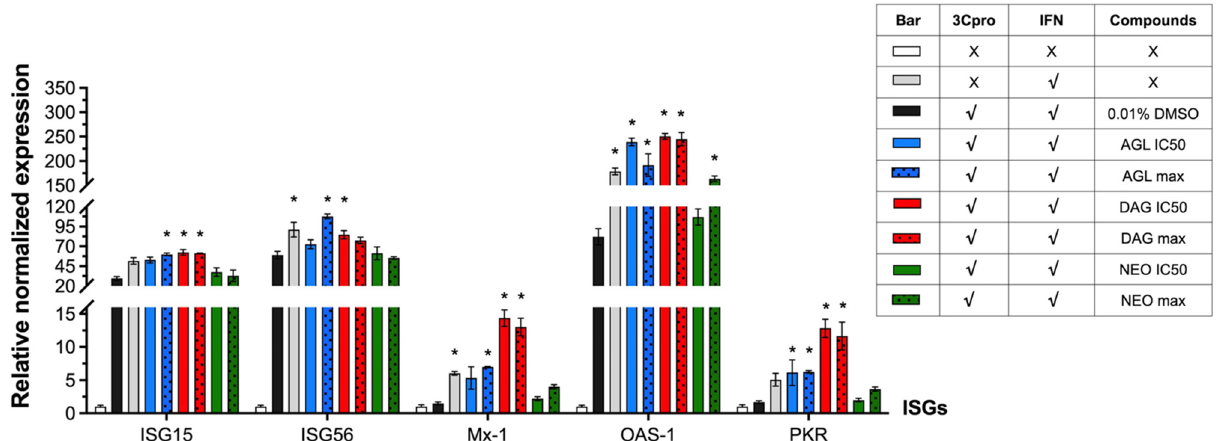
Figure 4. Interference of the andrographolides on inhibition of ISG expression by IFN-antagonist effect of FMDV 3C pro in HEK 293T cells. The cells were transfected with pBV_3ABCD and treated with the compounds at the doses of IC50 and IC90 or CC10. At 24 h after the compound treatments, cells were treated with 1000 IU/mL of IFN β for 8 h. The ISG mRNA levels were analyzed using RT-qPCR. The pBV and pBV_mu3ABCD were included as vector and 3C pro negative controls, respectively (Figure S2). The IFN β -treated, non-transfected cells were used as IFN β control. The data were displayed as the relative ISG mRNA levels of treatments and that of the mock-treated, non-transfected cell control. The experiments were performed in triplicates, and the relative data were presented by means and SD. The asterisks indicate p -value < 0.01 compared to the 3C pro expressing cells with 0.01% DMSO.